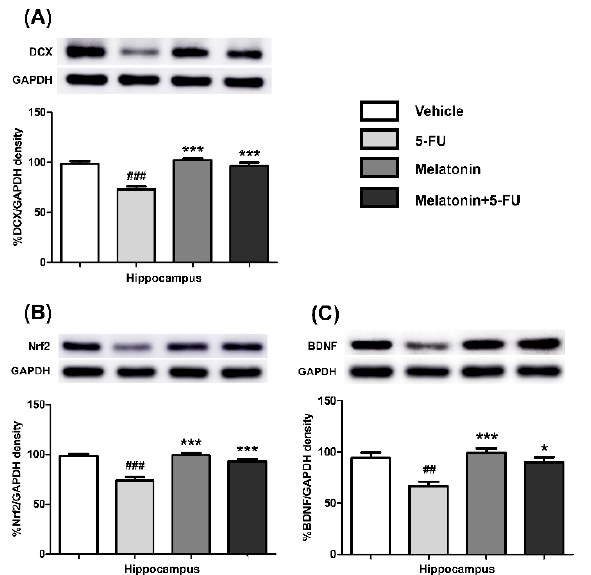
Figure 5. DCX ( A ), Nrf2 ( B ) and BDNF ( C ) protein expression in the hippocampus. ## p < 0.01 and ### p < 0.001 compared with the vehicle group. * p < 0.05 and *** p < 0.001 compared with the 5-FU group. Doublecortin: DCX; nuclear factor erythroid 2-related factor 2: Nrf2; brain derived neurotrophic factor: BDNF.